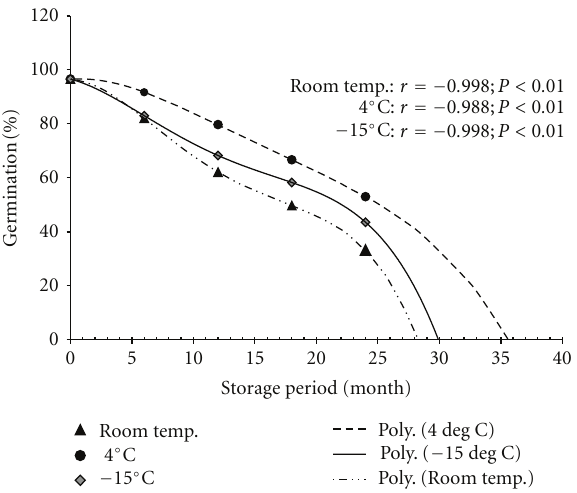
Figure 5: Seed viability (expressed as germination) as a ff ected by storage period for di ff erent storage conditions in Swertia chirayita ( cumulative data from all populations